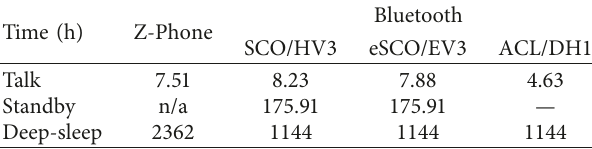
Table 4: Power consumption: Z-Phone vs Bluetooth. Time